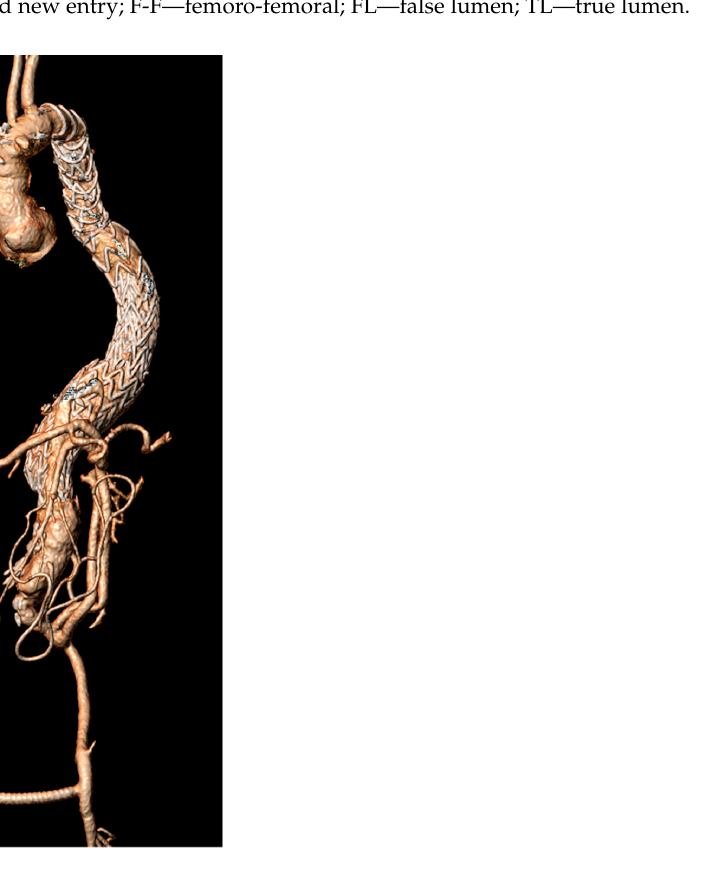
Figure 5. Postoperative 3D computed tomography angiography illustrating the final result after the hybrid reconstruction. hybrid